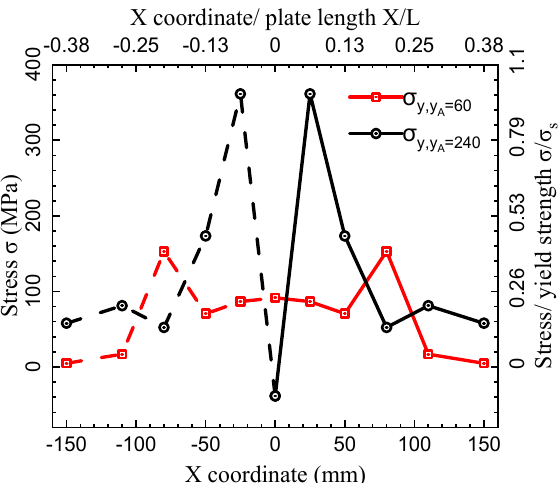
. and 𝐿 (cid:3052) (cid:3250) (cid:2880)(cid:2874)(cid:2868) (cid:3250) (cid:2880)(cid:2870)(cid:2872)(cid:2868)